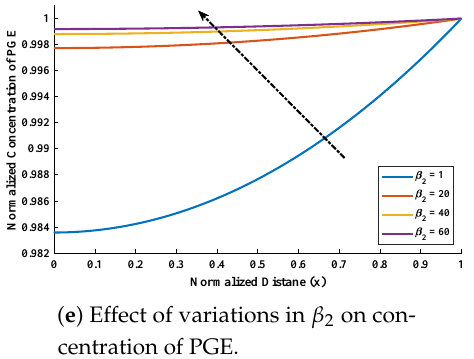
Figure 6. Influence of variations in different parameters on the normalized concentration of CO 2 and PGE.